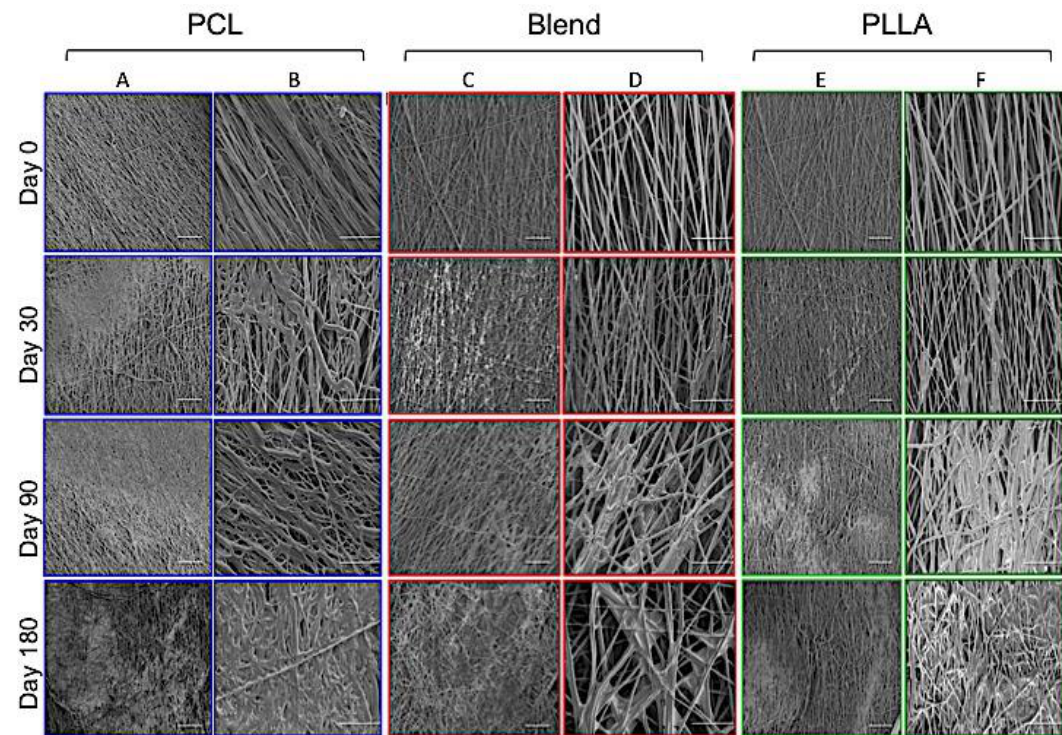
Figure 1. Scanning electron microscopy micrographs of polycaprolactone (PCL) ( A and B ), 50:50 PCL:PLLA (poly(L-lactic) acid) blend ( C and D ) and PLLA ( E and F ) electrospun fibers at time zero and following incubation in phosphate buffered saline solution at 37 °C for 30, 90 and 180 days. Columns A, C and E represent low magnification images (×500) (scale bar = 100 μm); columns B, D and F are high magnifications images (×1500) (scale bar = 20 μm).